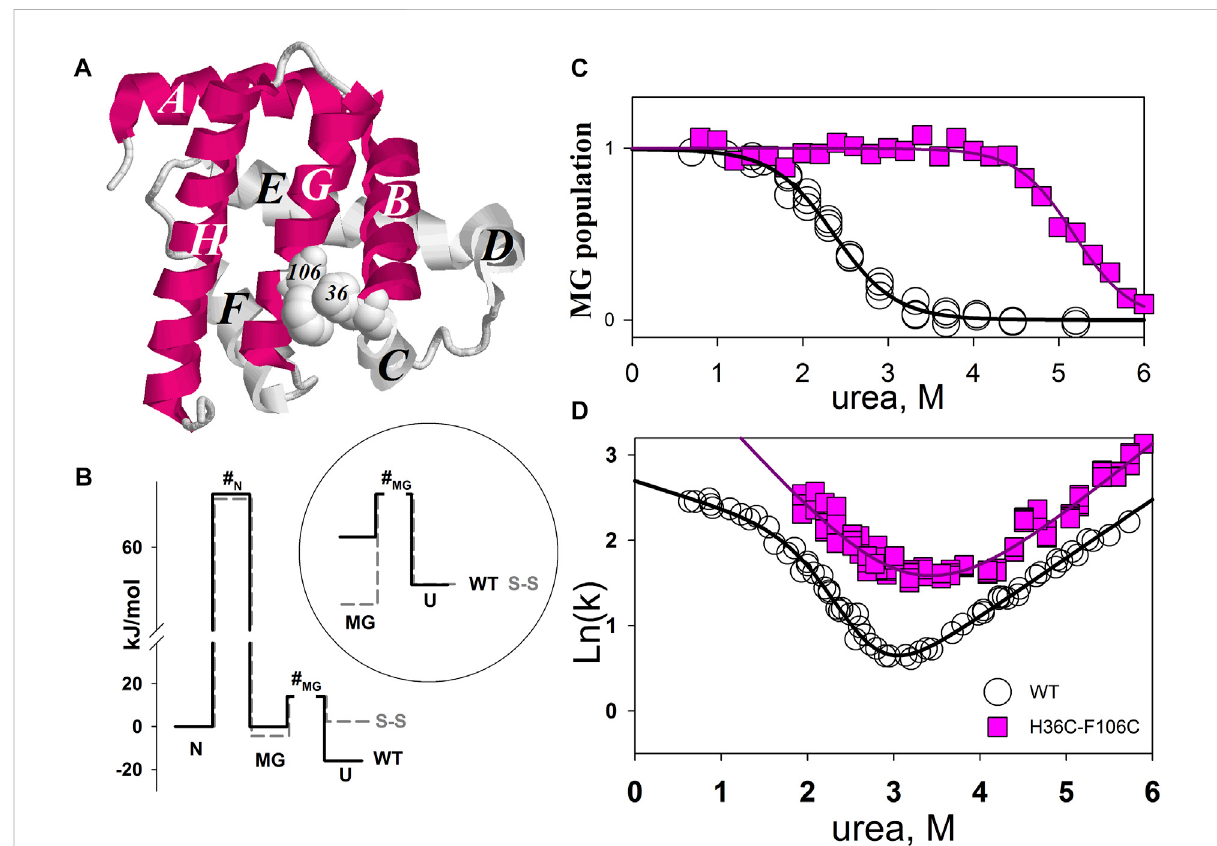
FIGURE 3 (A) 3Dstructureofmyoglobin.LettersfromAtoHidenti fi es α -helices. α -helicesfolded fi rst(JenningsandWright,1993)areshowninred.Amino acids H36 and F106 that have been substituted by cysteines are shown in volume. (B) Free energy pro fi les of wild-type (WT) and mutant (S-S) apomyoglobin calculated from molten globule state population plots (C) and chevron plots (D) . N, native state; I, intermediate state; MG, molten globule intermediate state; #, transition state; U, unfolded state. Free energy pro fi les calculated for proteins at 4.3 M urea, 11 ° C, pH 6.2 (Baryshnikova et al., 2005b). There is always some arbitrariness in comparing the energy pro fi les of different proteins with each other, since it is impossible to calculate the absolute values of free energies, only their relative values are calculated. The cysteine bridge changes the entropy of the proteinunfoldedstateand,accordingly,increasesthefreeenergyoftheunfoldedstate,soweassumedthatacomparisonofthefreeenergypro fi les aligned with the native state would provide a clearer understanding of changes in the energy landscape of mutant apomyoglobin. Additionally, the circle shows a part of the free energy pro fi le (transition between MG and U states) aligned with the unfolded